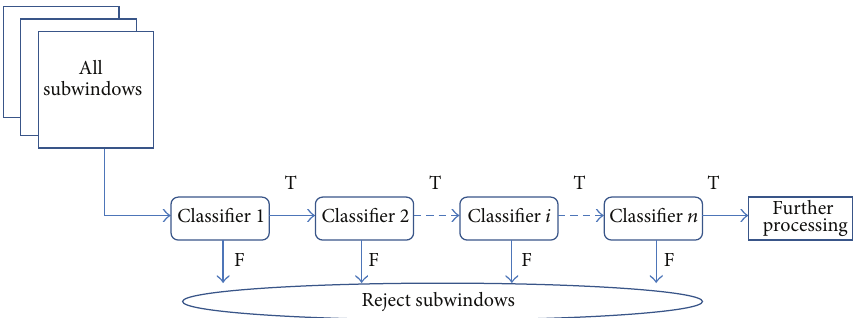
Figure 2: Flow chart of the cascade AdaBoost detector. Each classifier in cascade AdaBoost detector works independently, and the minimum true positive and the maximum false alarm rates of these stages are the same. Only these subwindows accepted as true positives by all stages of the detector are regarded as targets. “ T ” means that true candidates of these subwindows passed the verification of each classifier, and “ F ” means that these false candidates are rejected by the corresponding classifier.